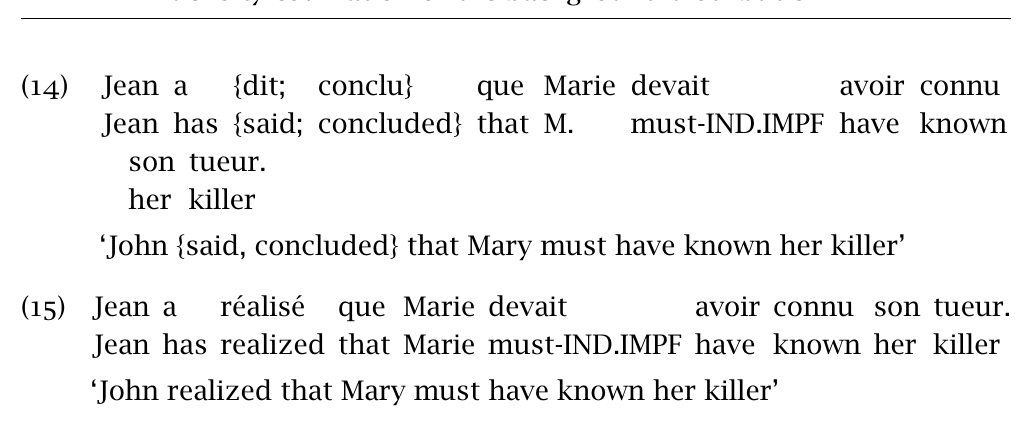
Acceptability ratings (from 1 = unacceptable to 7 = completely acceptable) for epistemics ( might and must ) under desidera- tives/directives, doxastics/argumentatives, and semi-factives. Gray bars indicate proportion of responses and solid lines kernel density estimation of the background